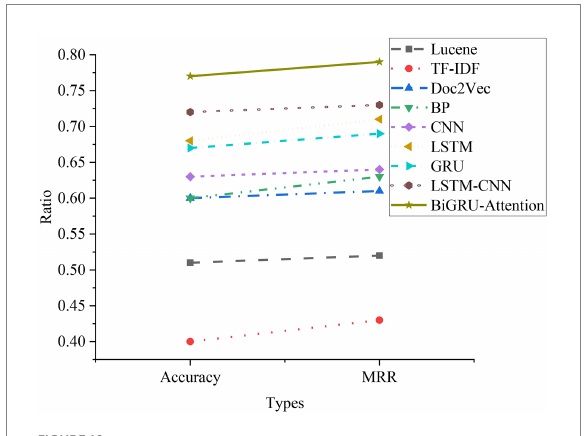
FIGURE 19 Comparison of experimental results of all models.